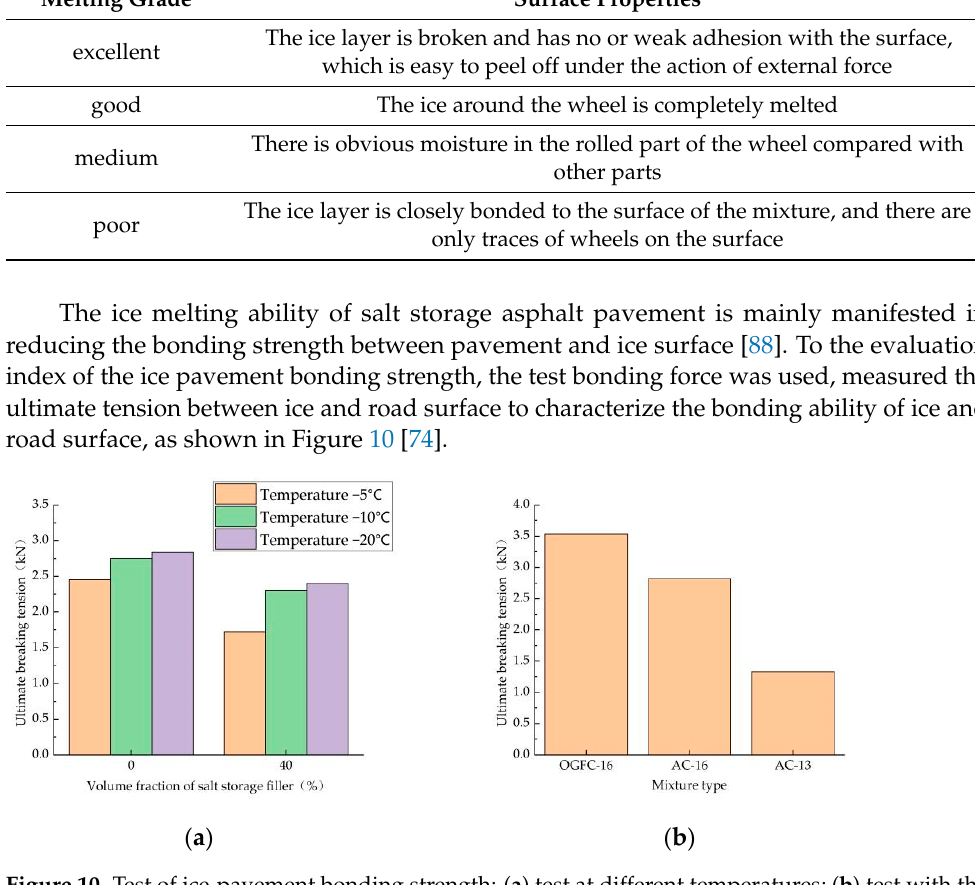
Figure 10. Test of ice-pavement bonding strength: ( a ) test at different temperatures; ( b ) test with the different type mixtures.